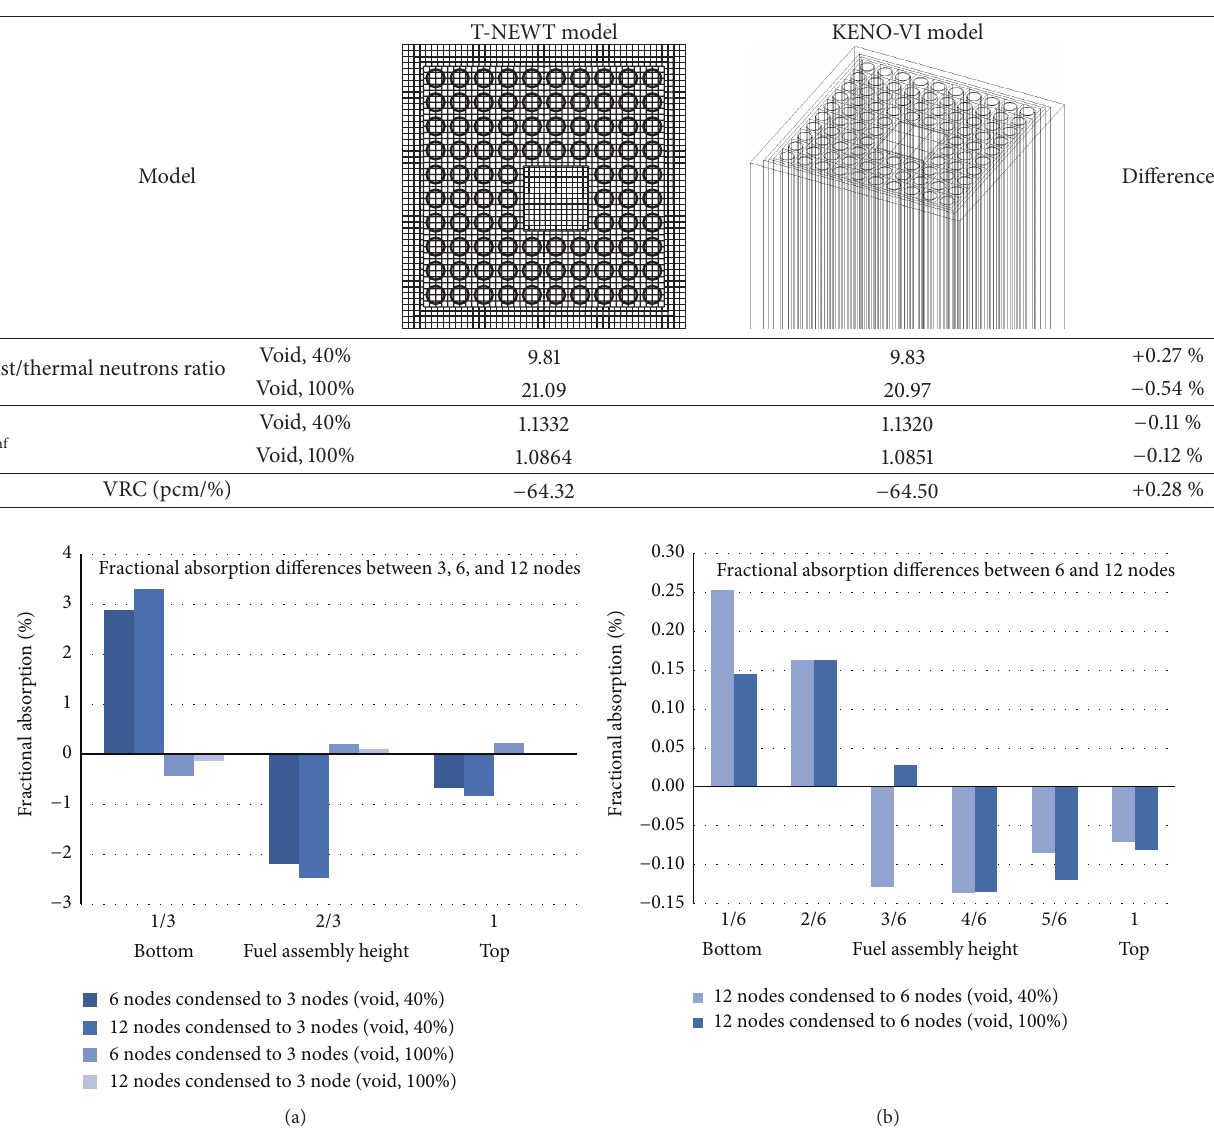
Table 2: T-NEWT model versus KENO-VI module.